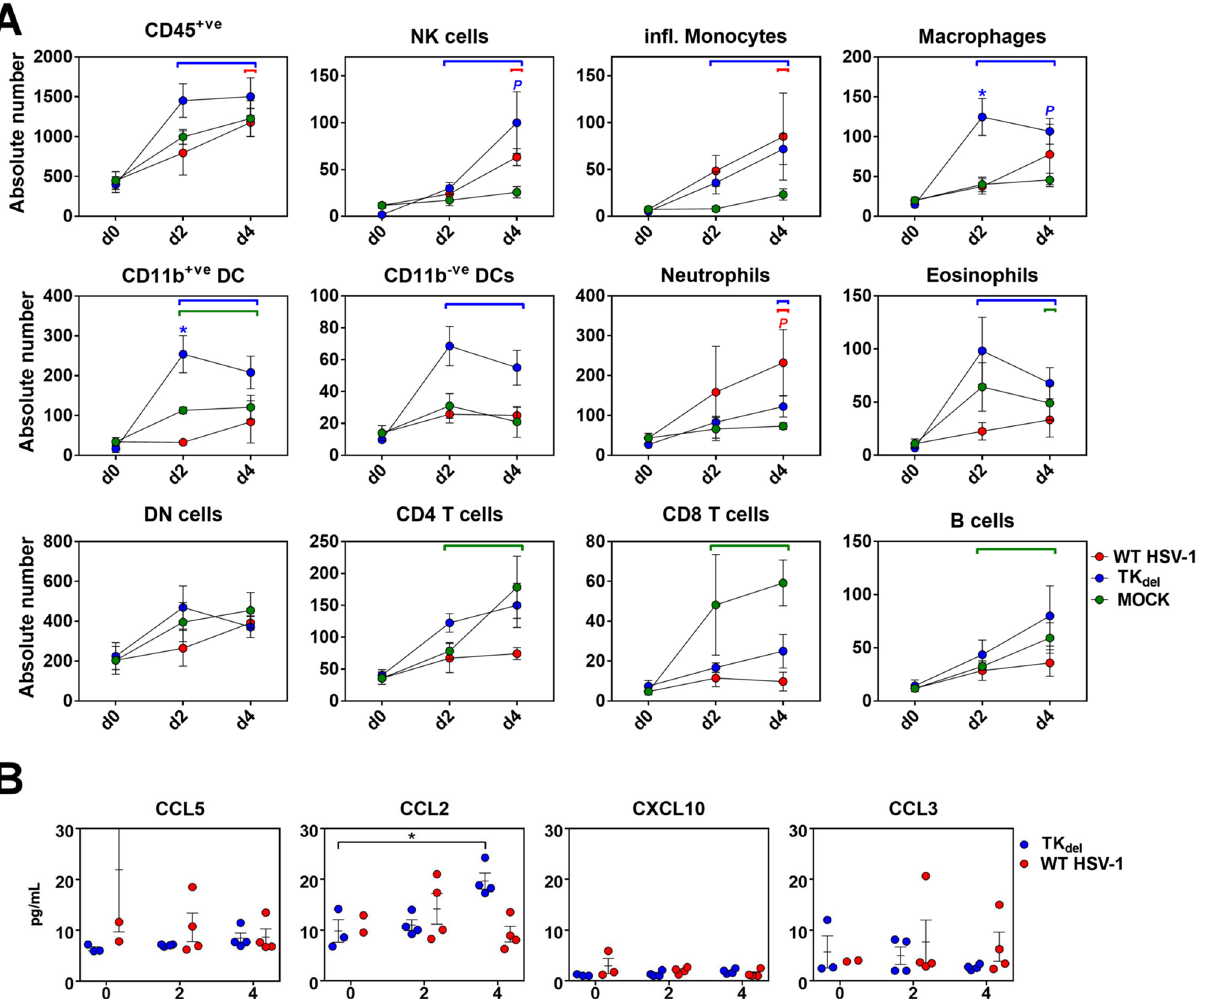
Figure 7. Immune subsets and inflammatory chemokines in the lip contralateral to prime. Naïve mice were infected with WT HSV-1, PBS (Mock), or TK del . On different days for each group, immune subsets were defined and absolute numbers enumerated from single cell suspensions by flow cytometry from lip tissue contralateral to the inoculation site ( A ), or inflammatory chemokines were quantified in non-denatured lip tissue lysates ( B ). Colored bars indicating significant difference from uninfected tissue on day 0. Blue asterisk indicates a significant difference for TK del compared to PBS mock infection (green) and WT HSV-1 ( p < 0.03; permutation test ). Colored P indicates a significant difference between the color-corresponding group and the Mock group. Black asterisks indicate a significant difference ( p < 0.03; T-test ). Each point represents n = 4 individual biological replicates. Figures were formulated using Flowjo, Excel and